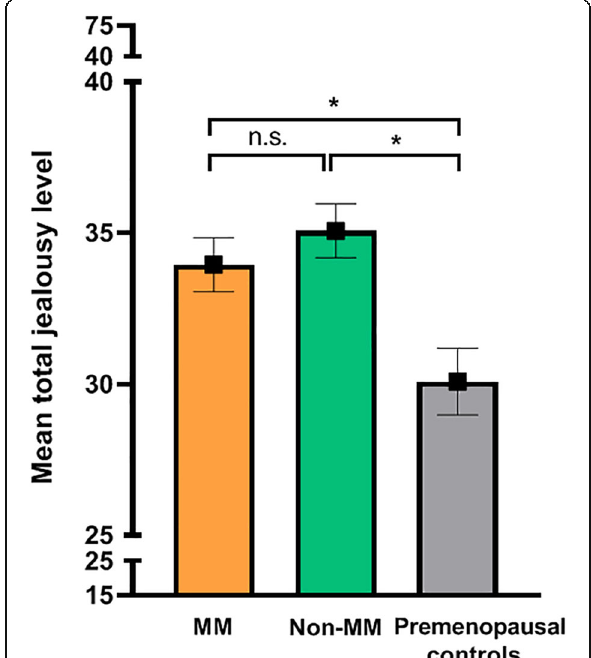
Fig. 2 Mean of total jealousy levels controlled for age, relationship duration and hormonal status. Legend: Premenopausal women: MM = menstrual migraine; non-MM = non-menstrual migraine; Premenopausal non-migraine controls. Jealousy levels were determined using the validated Buunks Jealousy scale (score between 15 and 75). Depicted levels are mean ± SEM.*= statistically significant difference, n.s. = non-statistically significant difference